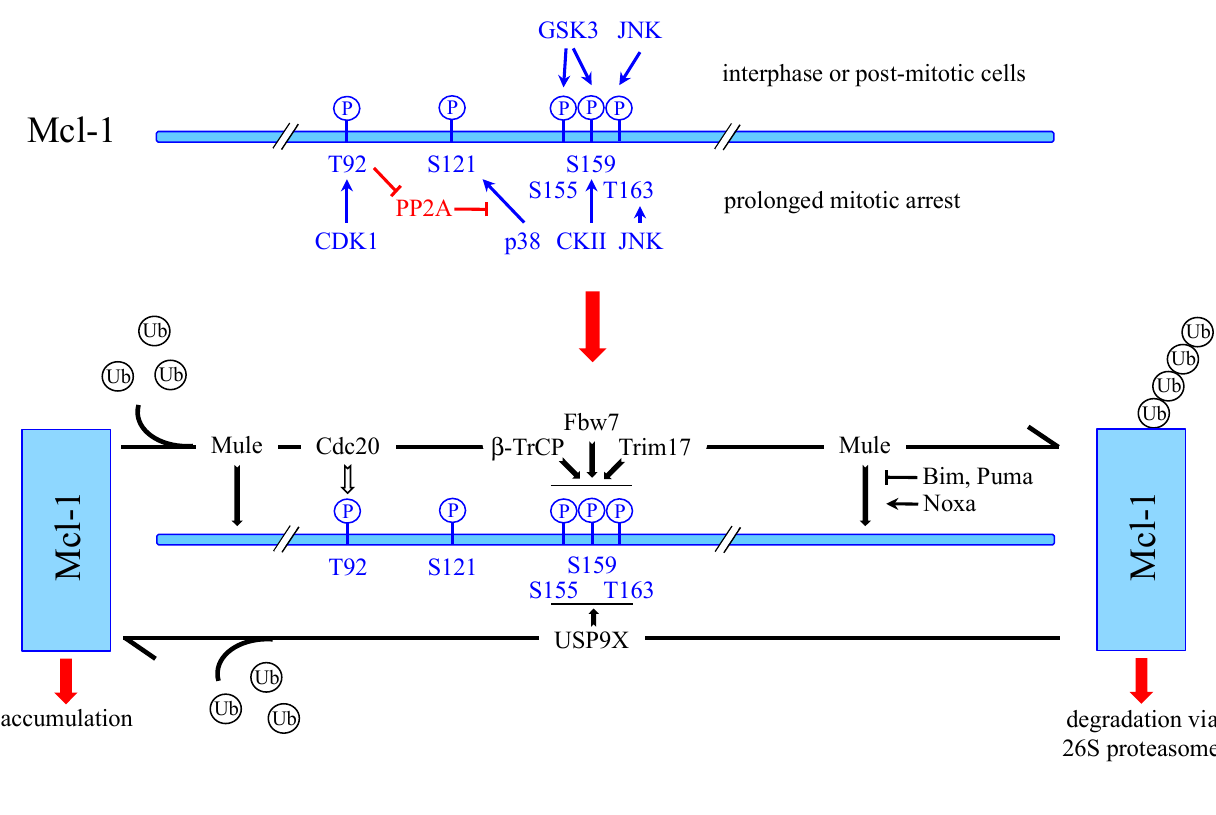
Figure 3. Regulation of Mcl-1 stability. Mcl-1 can be phosphorylated by several protein kinases (in blue) at indicated residues. In interphase or post-mitotic cells, JNK phosphorylates Thr163 which primes Mcl-1 for phosphorylation by GSK3 at Ser159 and Ser155. During prolonged mitotic arrest, p38, CKII and JNK phosphorylate Ser121, Ser159 and Thr163. CDK1 may indirectly enhance phosphorylation at these sites by phosphorylating Thr92, thereby triggering the dissociation of the phosphatase PP2A that would otherwise dephosphorylate Mcl-1. Phosphorylation of Ser155, Ser159 and Thr163 drives the recognition of Mcl-1 by its E3 ubiquitin-ligases SCF β -TrCP , SCF Fbw7 and Trim17 (in black). In addition, phosphorylation at Thr92 is required for Cdc20-mediated ubiquitination of Mcl-1, although direct ubiquitination of Mcl-1 by APC/C Cdc20 has not been demonstrated. In addition, the E3 ubiquitin-ligase Mule can interact either with the C-terminus of Mcl-1 through its BH3 domain, or within the N-terminal 30 amino acids of Mcl-1. Binding of Mule does not depend on Mcl-1 phosphorylation but it can be inhibited by the BH3-only proteins Bim and Puma. In contrast, Noxa increases the association between Mule and Mcl-1 through an as yet unknown mechanism. Ubiquitination of Mcl-1 targets it for proteasomal degradation. It can be opposed by the deubiquitinase USP9X that directly removes degradative Lys-48-linked polyubiquitin chains from Mcl-1, which results in Mcl-1 stabilization. Phosphorylation at Ser155, Ser159 and Thr163 inhibits the binding of USP9X to Mcl-1. In cancer cells in which Mcl-1 degradation is not dependent on GSK3, ERK-mediated phosphorylation of Thr163 stabilizes Mcl-1 (not depicted